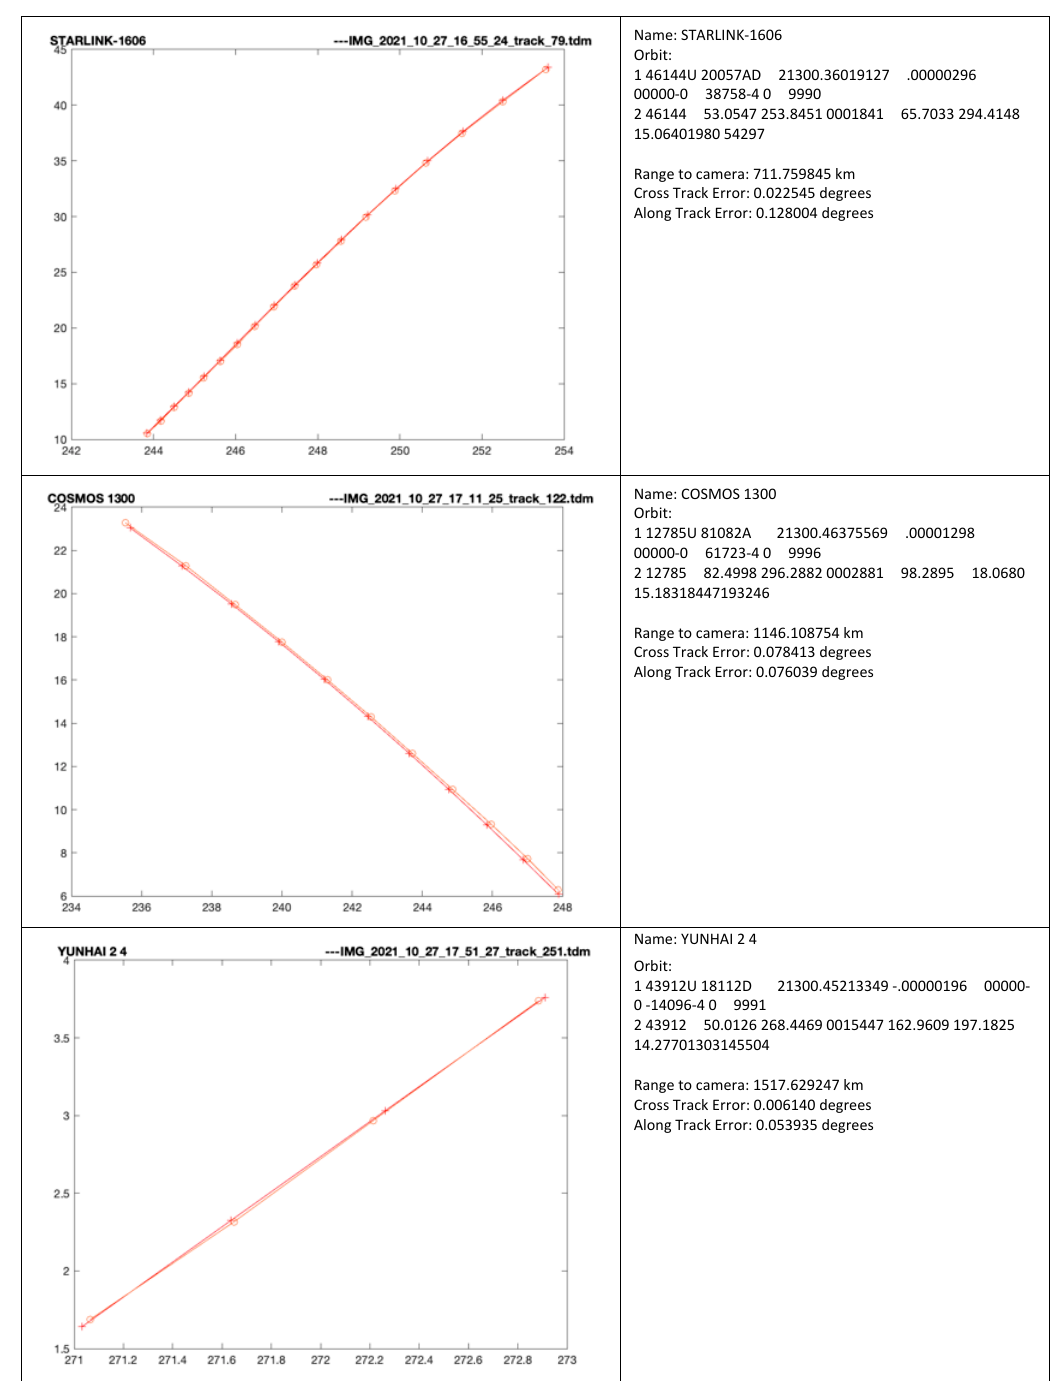
Figure 21. Selection of detected satellites (SW sequence). In the left column we can see the trajectory comparison between the prediction (marked with X) and the measurement (marked with O), and in the right column we see the satellite name, the orbital parameters, and the errors. Frame from a sequence captured in Cluj-Napoca, at sunset, facing south-west.